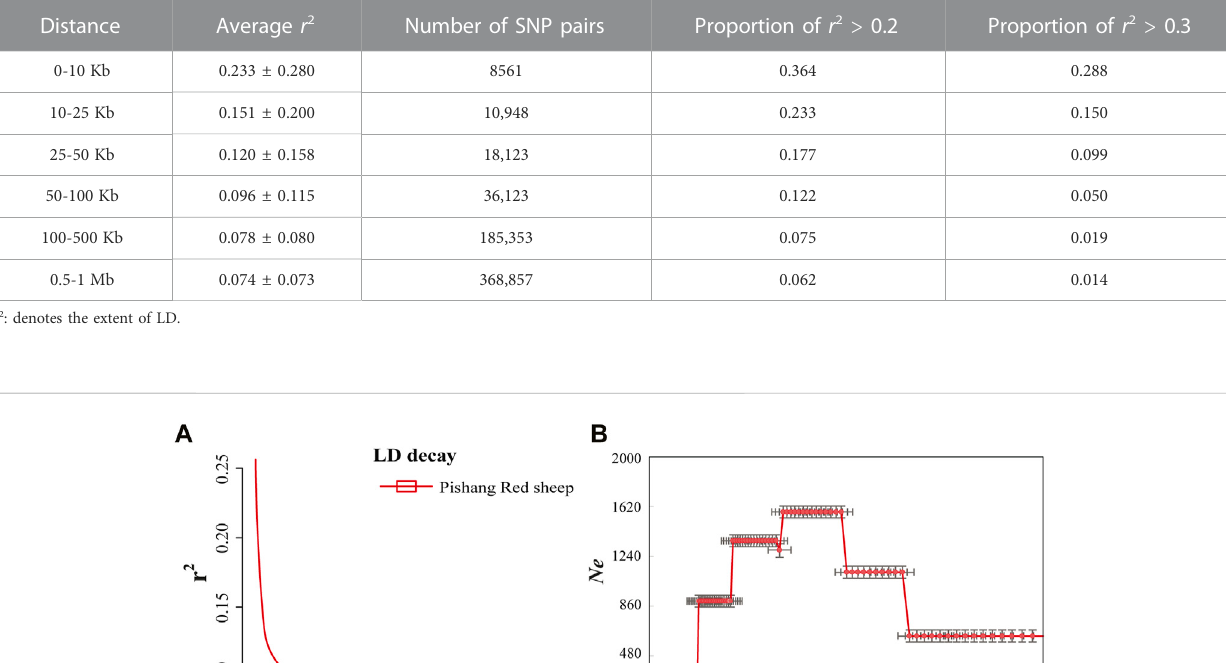
TABLE 1 LD statistical analysis between different distances (0 – 1 Mb).